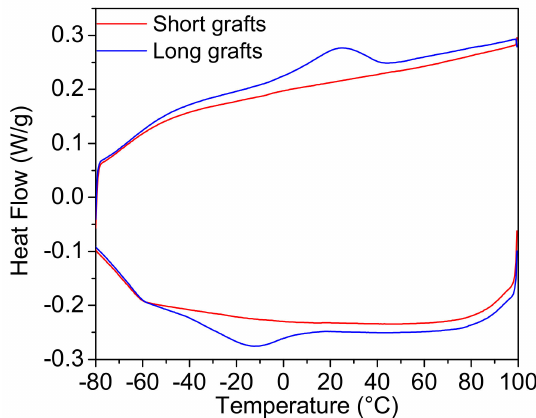
Figure 4. DSC traces of the cooling and the 2nd heating run for silica nanoparticles with short and long graft